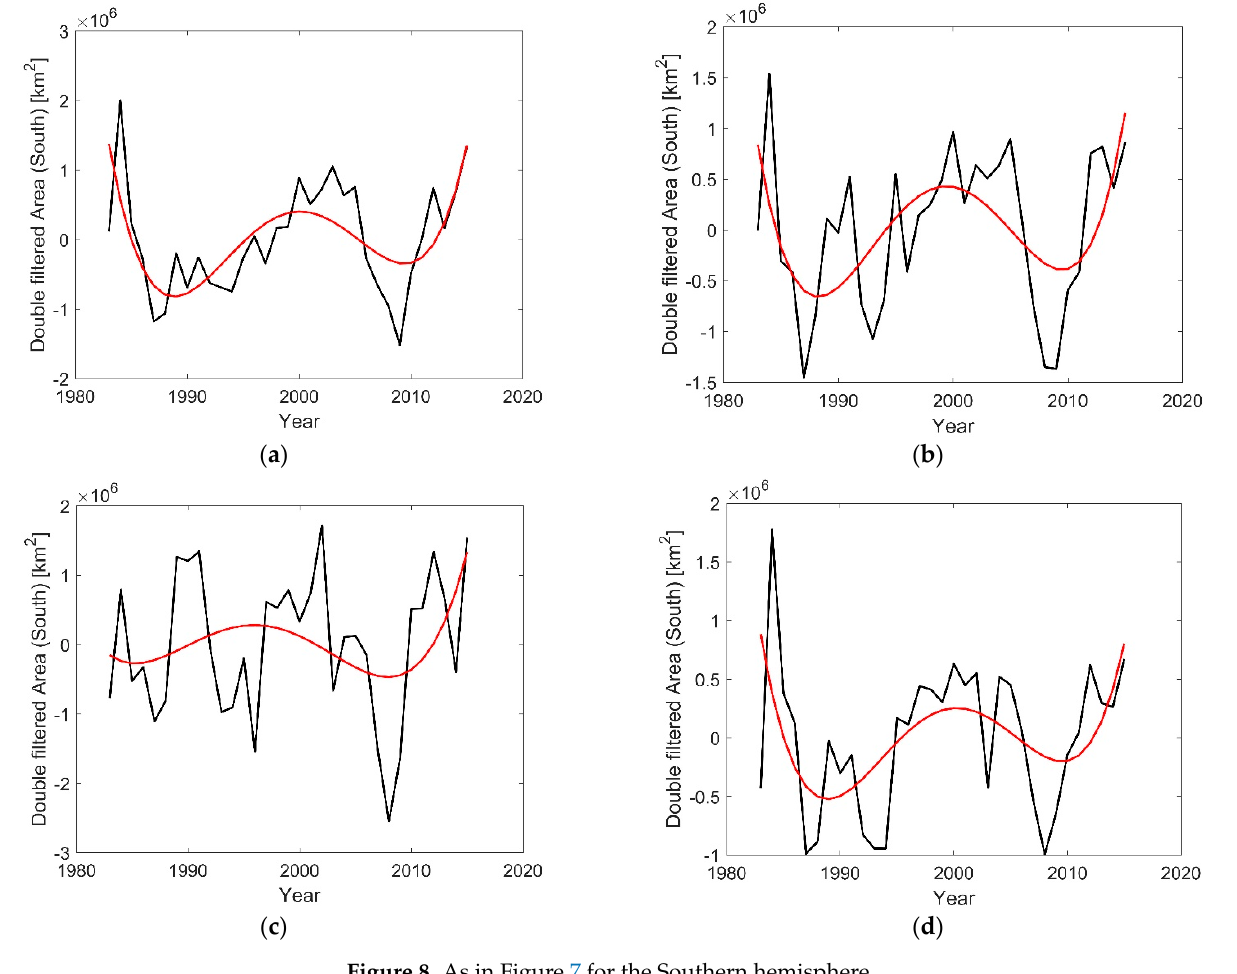
Figure 8. As in Figure 7 for the Southern hemisphere.